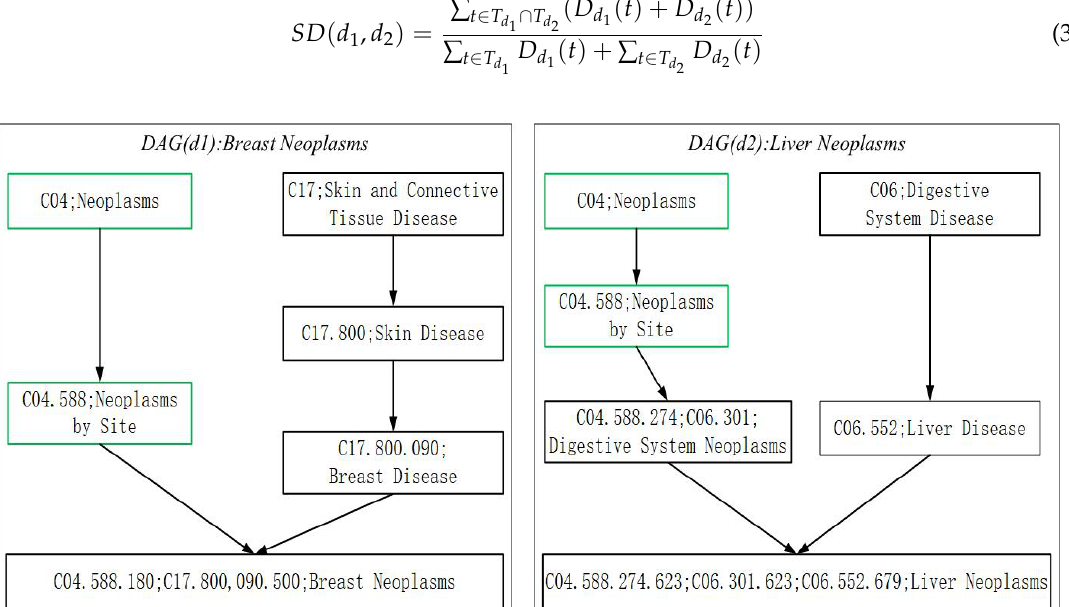
Figure 2. The DAGs of the disease Breast Neoplasms and Liver Neoplasms. In addition, the disease term and its identification numbers are included in corresponding node. The common terms of the two diseases are illustrated by green